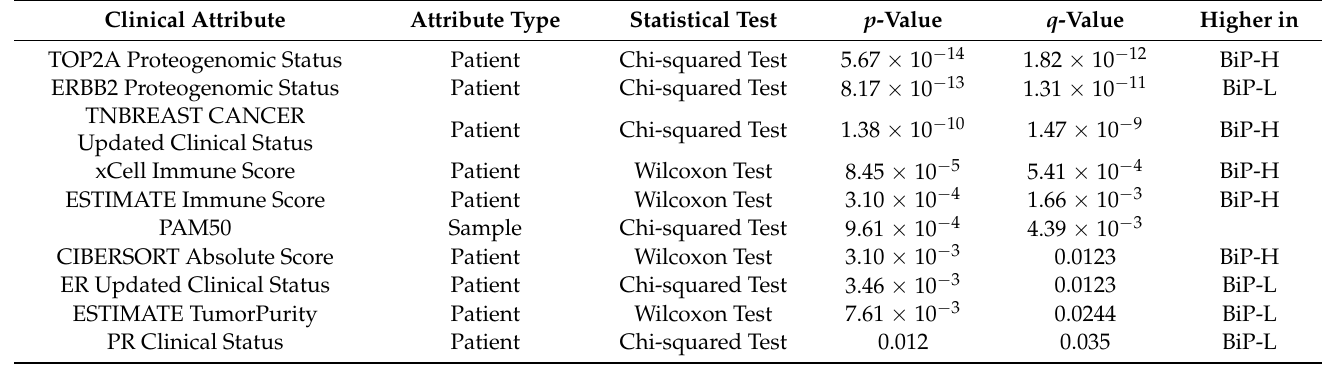
Table 1. Association of BiP-High (BiP-H) and BiP-Low (BiP-L) groups in CPTAC dataset with clinical factors.